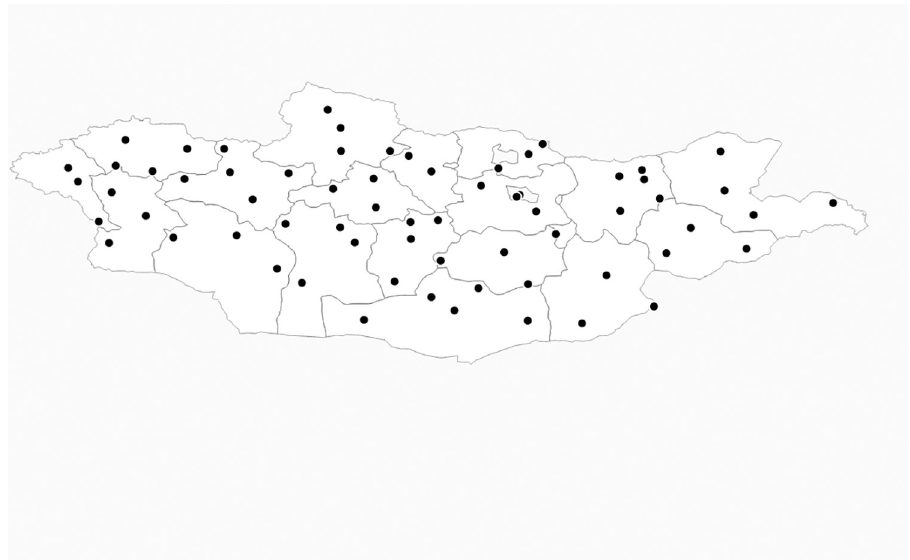
Fig 1. Physical map of Mongolia with weather station locations. Source: Authors’ composition based on MIDAS/ CEDA dataset.